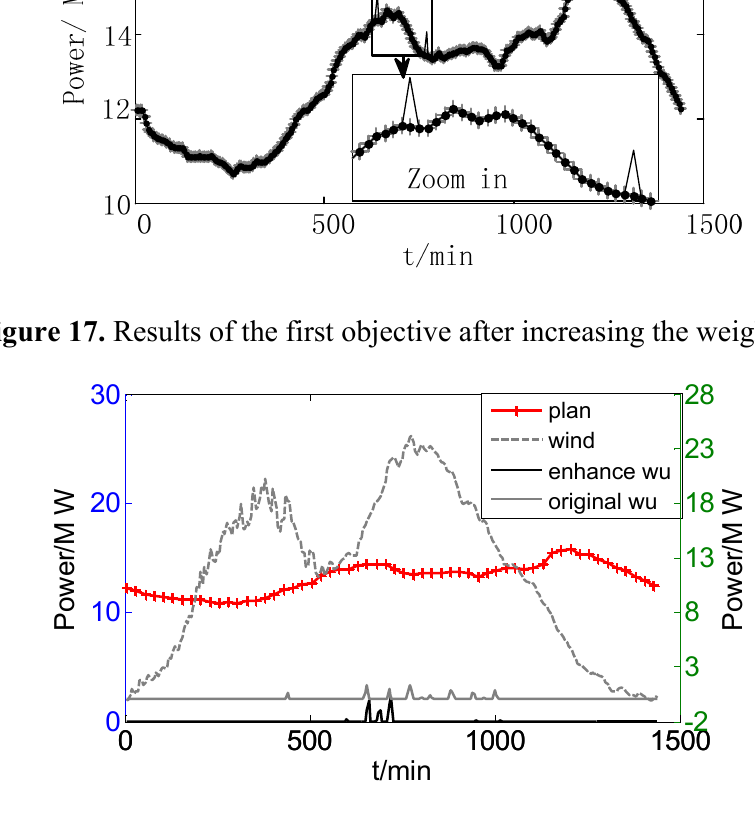
Figure 18. Simulation results for the second objective after strengthening the weight. To show the details of the reduction of wu p , the case of the minute 435 was tested again with the t same data. For the original weight of wu p t wu p t Table 5. Case analysis of the increased